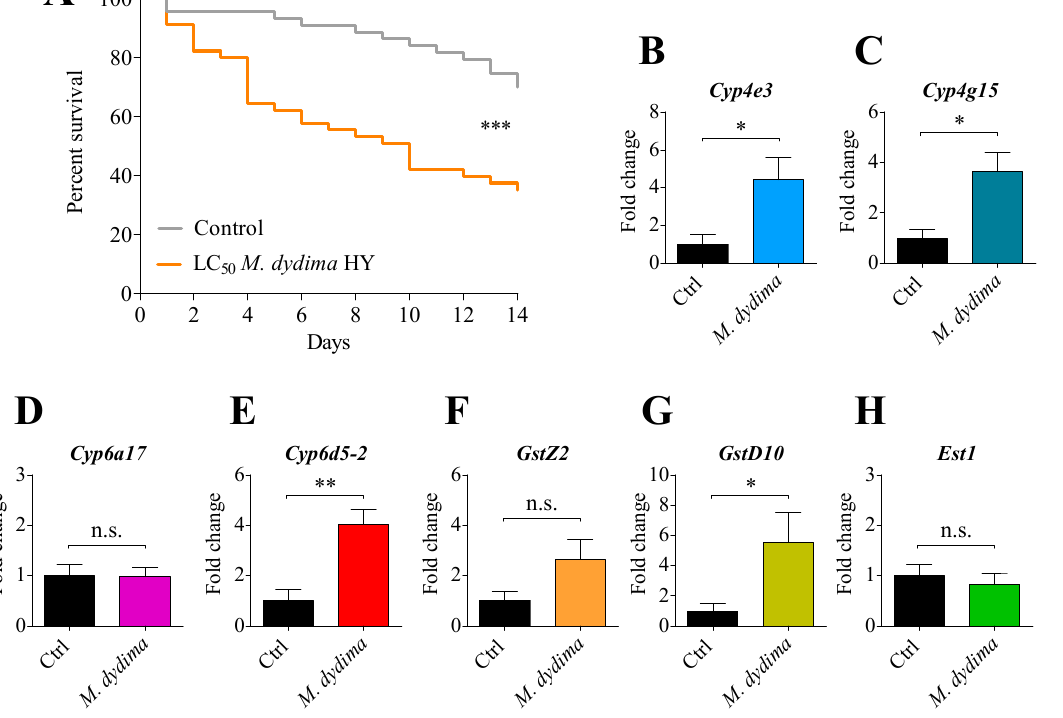
Figure 3. Effect of M. didyma contact exposure on survival and detoxification enzyme expression. Survival assay of D. suzukii adults after M. didyma HY LC 50 exposure ( A ). Fifteen flies for each biological replicate were scored for survival, and three biological replicates were performed. For survival assay, statistical analyses were performed using the log-rank test. *** p < 0.001. D. suzukii metabolic gene expression levels after 48 h of exposure to the M. didyma HY LC 50 ( B – H ). Data represent means ± SEM of three independent experiments performed in triplicate. n.s. not significant; * p < 0.05, ** p < 0.01 vs. control according to Student’s t